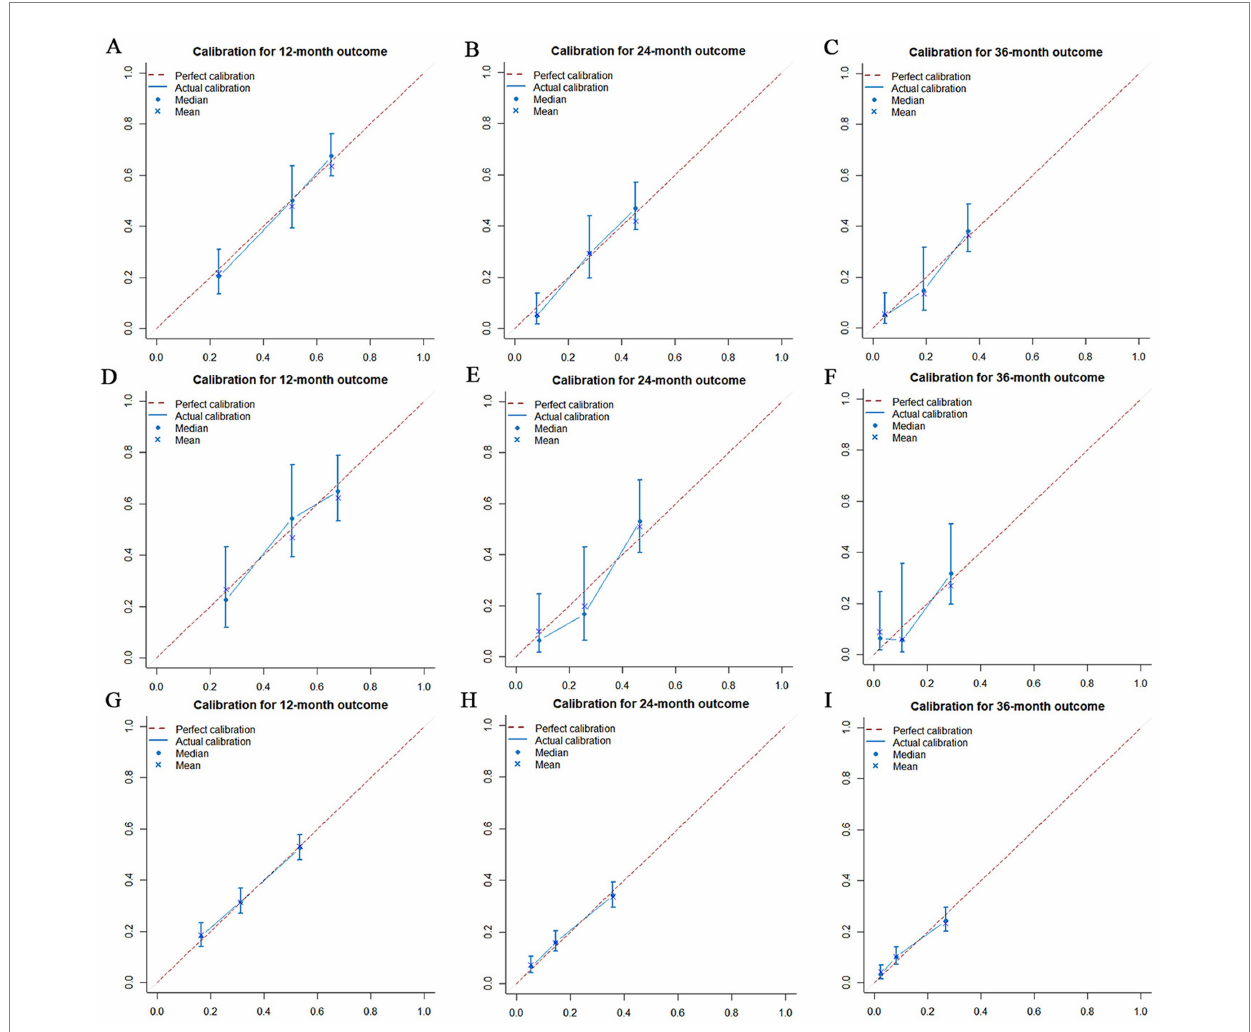
FIGURE 11 Calibration curves for overall survival (OS) at 12 months (A) , 24 months (B) and 36 months (C) in the training set, Calibration curves for OS at 12 months (D) , 24 months (E) and 36 months (F) in the validation set and Calibration curves for OS at 12 months (G) , 24 months (H) and 36 months (I) in the extended validation